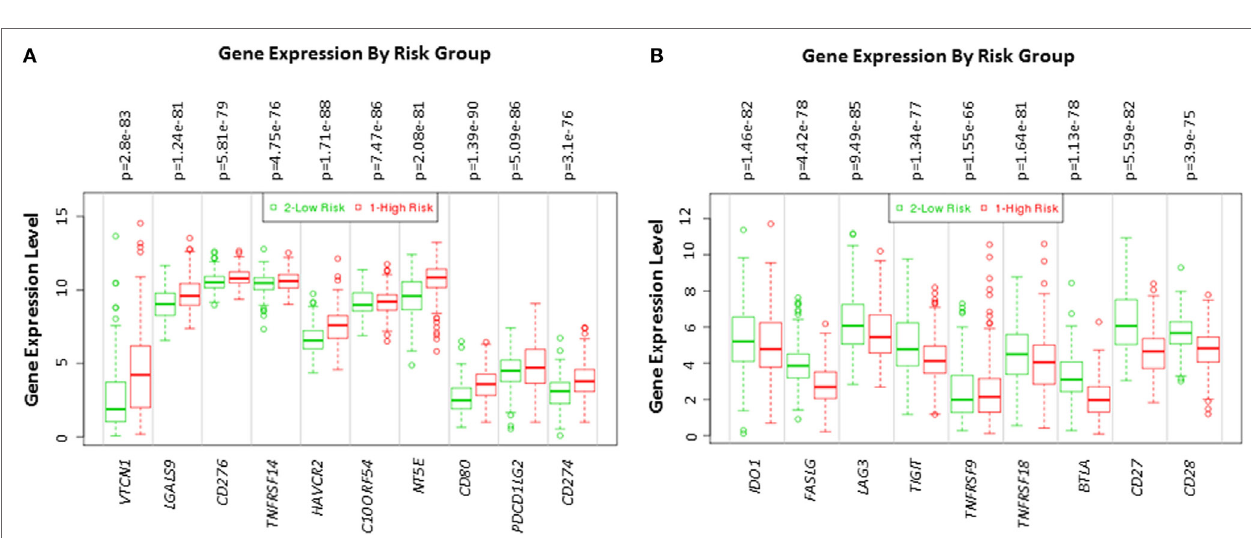
FigUre 2 | Gene expression of immune modulators in HCC patients based on risk group. Box plot of gene expression of (a) immune modulators that statistically correlate with high-risk prognostic score and (B) immune modulators that statistically correlates with low-risk prognostic score in 422 HCC patients from the TCGA-Liver Cancer dataset. Risk assessed is risk of reduced survival. Red box represents high-risk group and green box represents low-risk group. Each gene is shown on the x -axis. X -axis also shows a p -value of the expression difference between the two risk groups. The expression levels are shown on the y -axis.